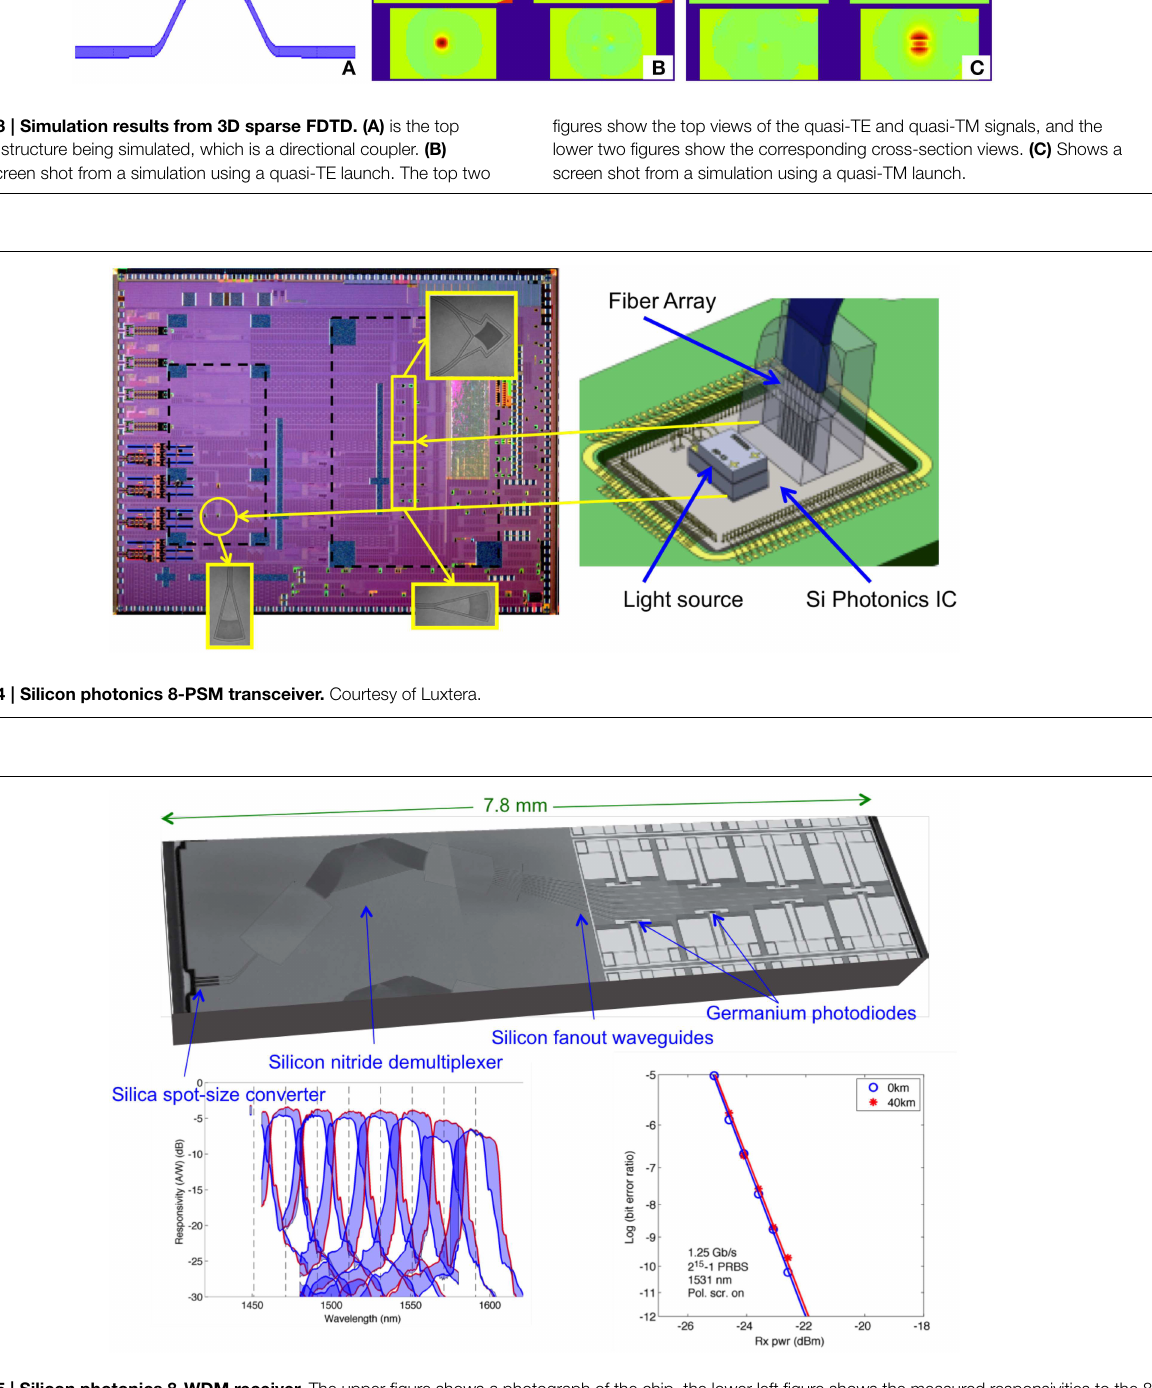
Frontiers in Physics |